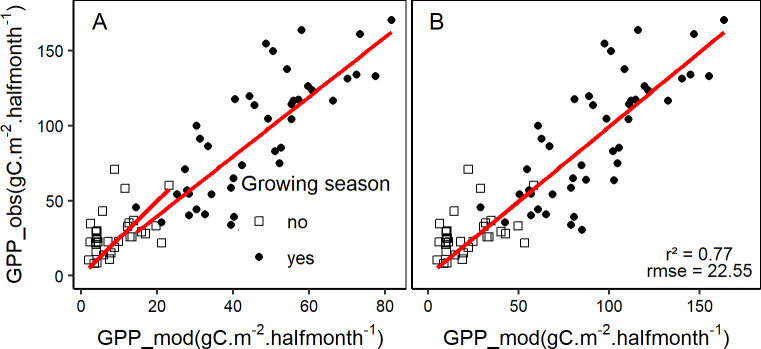
Observed vs. modelled GPP using the VPM model.(A) uncorrected VPM output, (B) seasonally corrected VPM output (correction factors of 2 and 2.51 for growing and non-growing season, respectively).